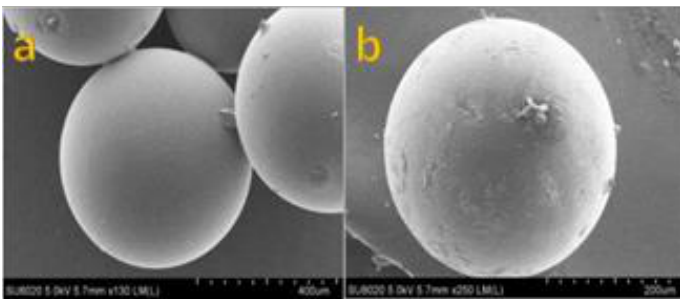
Figure 5. SEM images of resin; ( a ) Amberlite IR-120 before reaction with the magnification of 400 µm ( b ) resin after reaction at 318 K, 150 rpm, with the magnification of 200 µm.